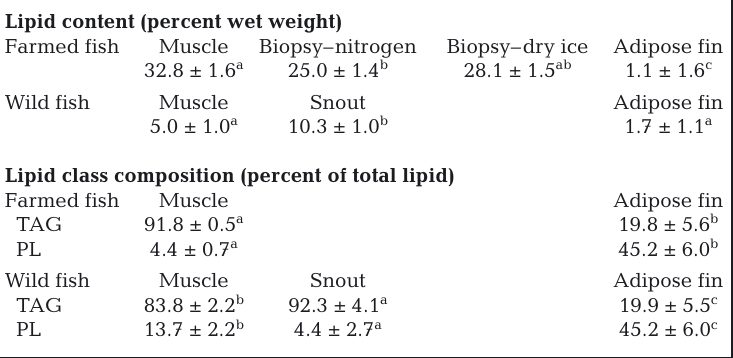
Table 2. Salmo salar . Fatty acid composition in the diet and in the adipose fin and muscle triacylglycerols (TAG) and total lipids (TOT) of maturing Atlantic salmon fed on a defined diet over 12 mo (percent of fatty acids). Data are means (±SEM) of 14 fish. Potential differences between the tissues were assessed by 2-way ANOVA and Tukey’s post hoc test. Main effects are given in the right columns—Tissue: effect of adipose fin and muscle; TAG: effect of TAG or TOT fatty acid methyl ester composition; Tissue × TAG: interaction of the 2; SFA: saturated fatty acids; MUFA: monounsaturated fatty acids; PUFA: polyunsaturated fatty acids. Significance was accepted at p < 0.05. Numbers within each line not sharing common superscript letters